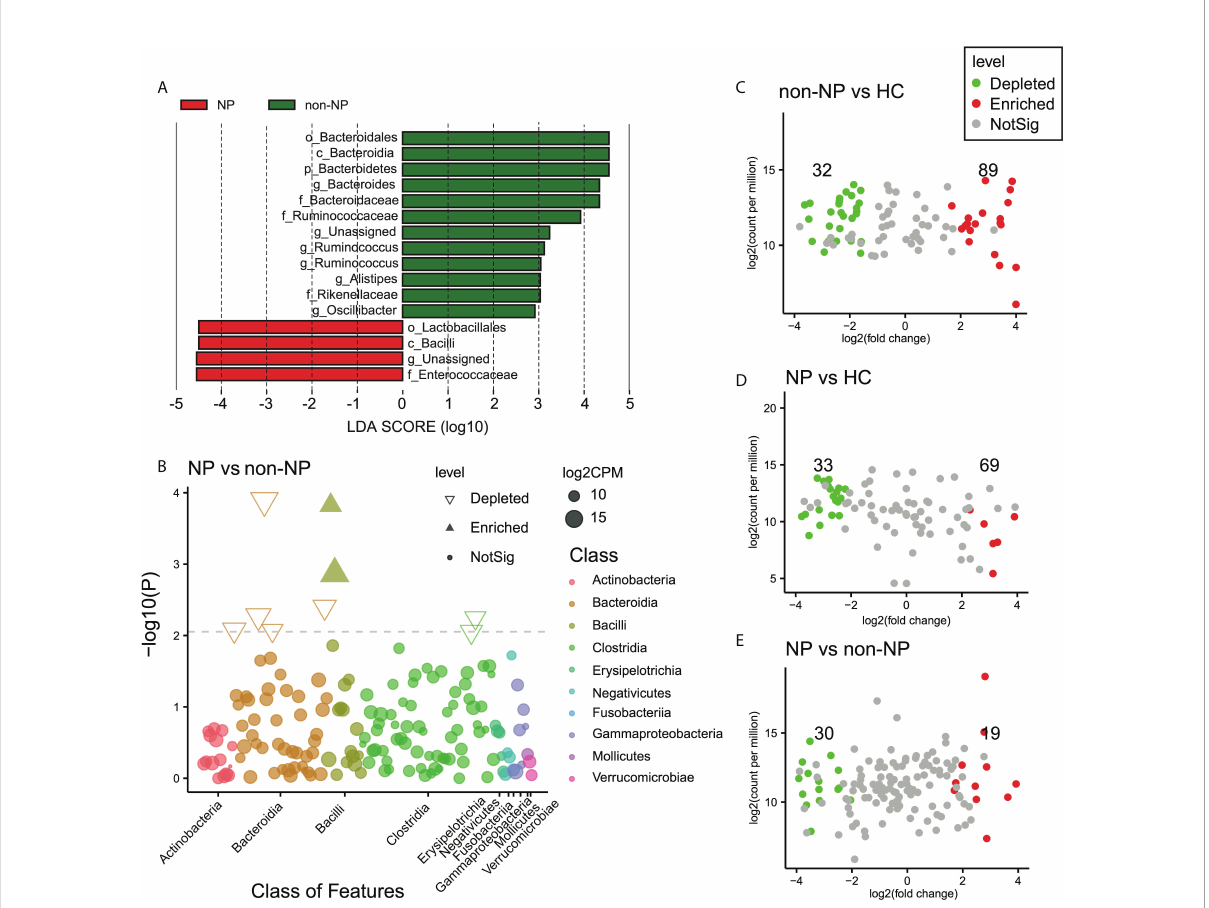
FIGURE 3 Differential bacteria taxa and ASVs between the NP, non-NP and HC groups (A) LefSE analysis comparison between the NP and the non-NP groups, bacterial taxa are listed with a LDA score > 2.0. Microbial taxa enriched in non-NP group were highlighted in green; c, o, f, and g represent class, order, family and genus, respectively. (B) Manhattan plot of differential taxa between NP and non-NP groups. The x axis represents the microbial taxa at the class level ranked by alphabetical order, and y axis represents -log10 (p value). Filled triangles, hollow inverted triangles, and solid circles indicate ASVs enriched, depleted, and without signi fi cant difference, respectively. The color of each marker represents the different taxonomic af fi liation of the ASVs, and the size corresponds to their relative abundances using log2 transformed CPM values. (C – E) Volcano plot. Each point represents an ASV, and signi fi cantly different ASVs are colored (non-NP vs HC, NP vs HC, NP vs non-NP; green = depleted in the former group; red = enriched in the former group; gray = not signi fi cant). NP, necrotizing pancreatitis; non-NP, non- necrotizing pancreatitis; ASV, amplicon sequence